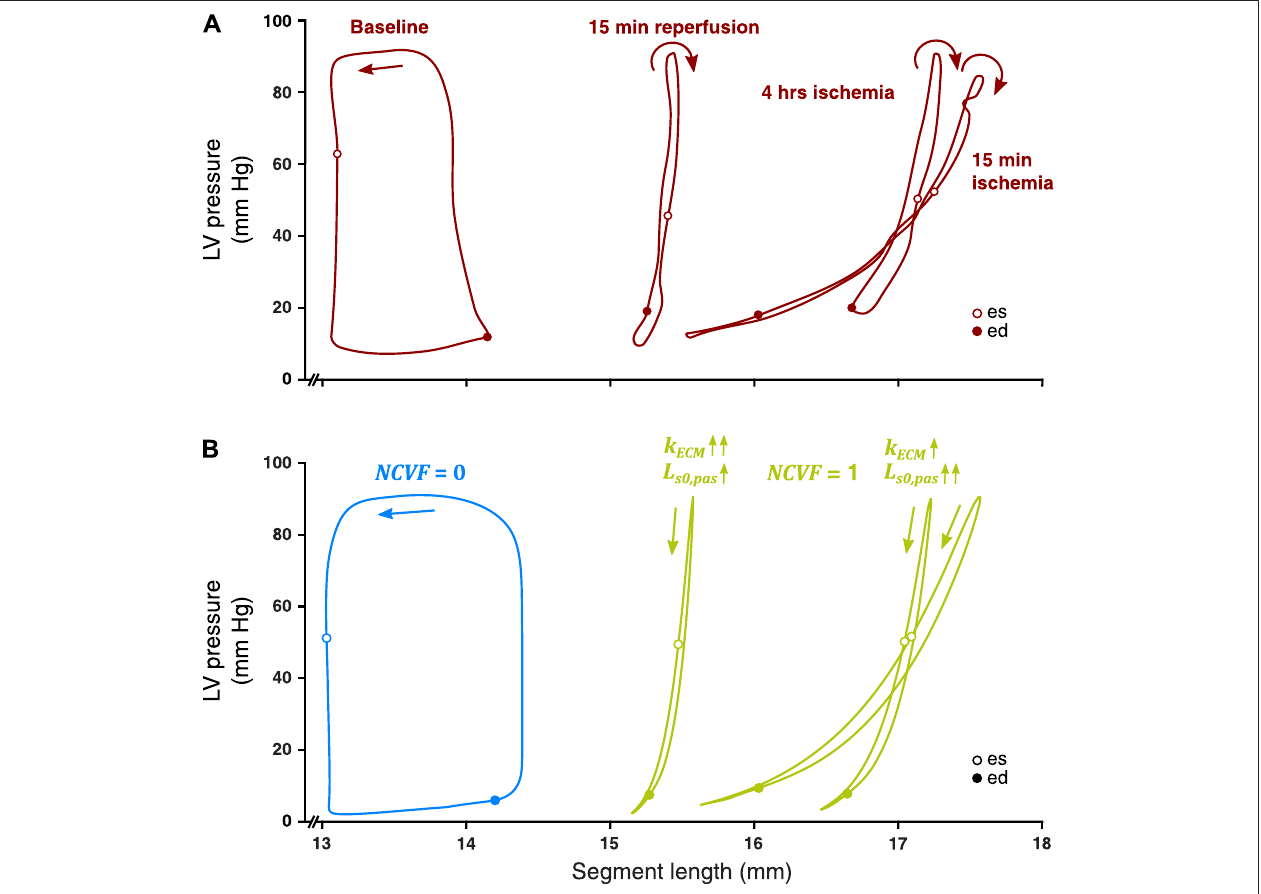
FIGURE 6 | Comparison between measured LV pressure-segment length loops in a representative dog after 15 min and 4 h of left anterior descending (LAD) coronary artery occlusion, followed by 15 min of reperfusion [ (A) , resketched from Lyseggen et al. (2005)] and simulated LV pressure-segment length loops (B) for no contractiledysfunction( NCVF =0,blueloop)andcompletecontractiledysfunction( NCVF =1,allthreegreenloops),wherenonlinearityparameter( k ECM )andzero-stress sarcomerelength( L s 0 , pas )werecalibratedforthegreenloopstomimic theexperimental measurements(valuescanbefoundin Table3 ).ed,end-diastole;es,end-